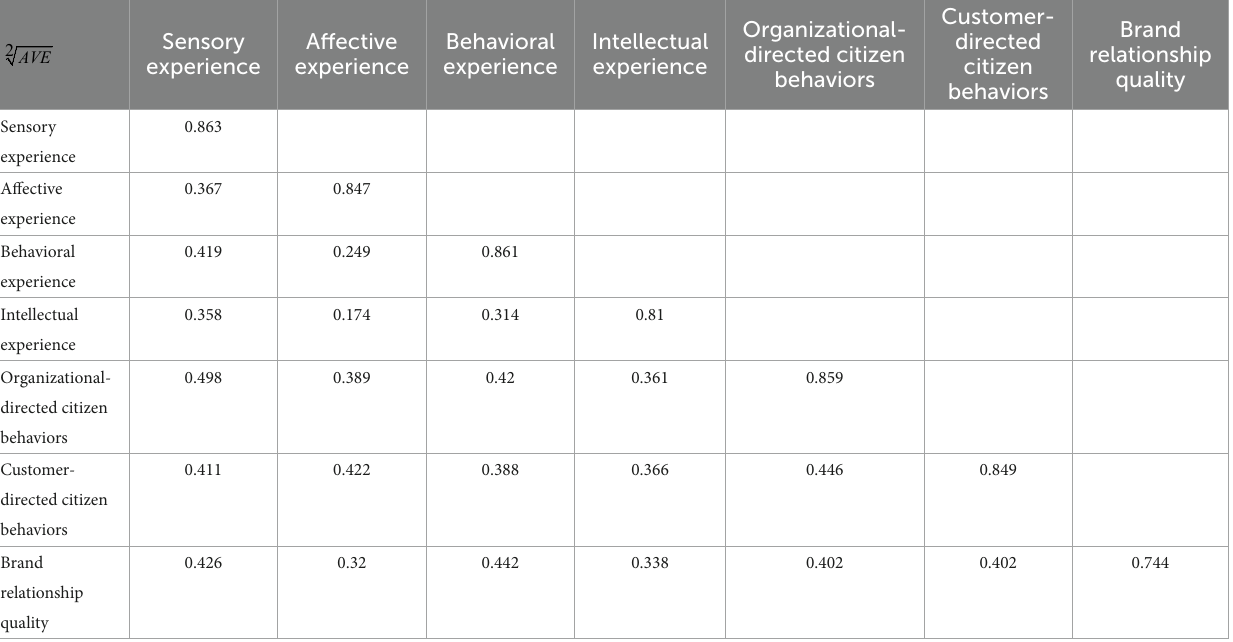
TABLE 5 Discriminant validity